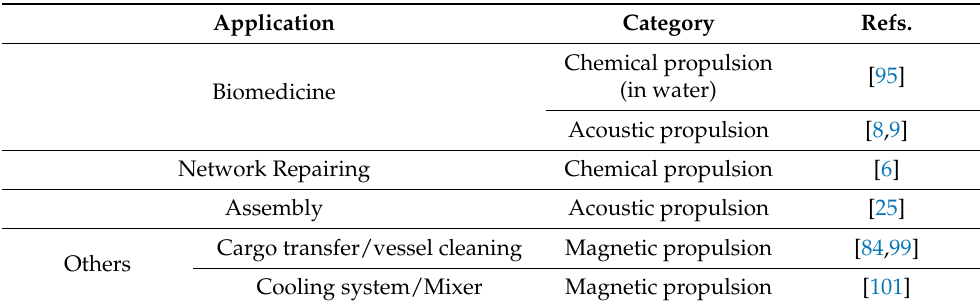
Table 6. The application of